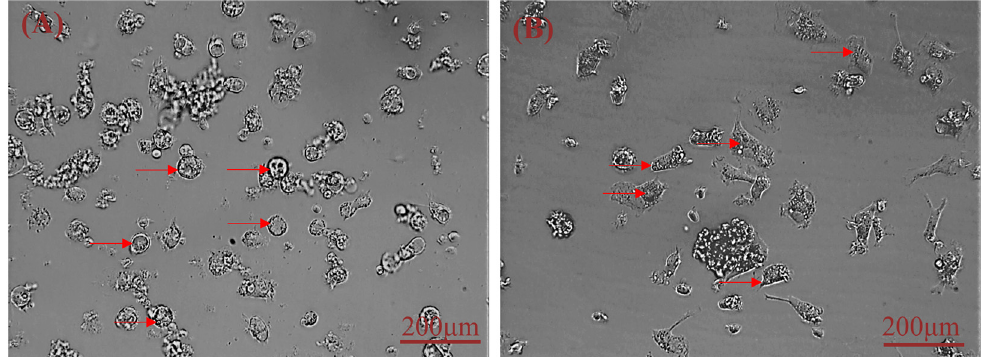
Figure 1. Morphological characteristics of isolated primary sheep hepatocytes (brightfield imaging). ( A ) Hepatocytes adhered to the surface after 2 days. ( B ) At low density, hepatocytes acquire an irregular polygon shape after 4 days. Note: red arrows indicate primary